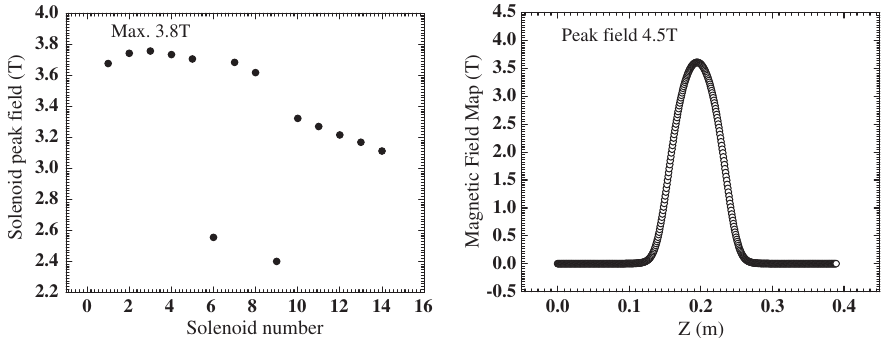
FIG. 10. The peak fields of the solenoids along the SC section of Injector I (left) and the designed field extension of the solenoid (right).